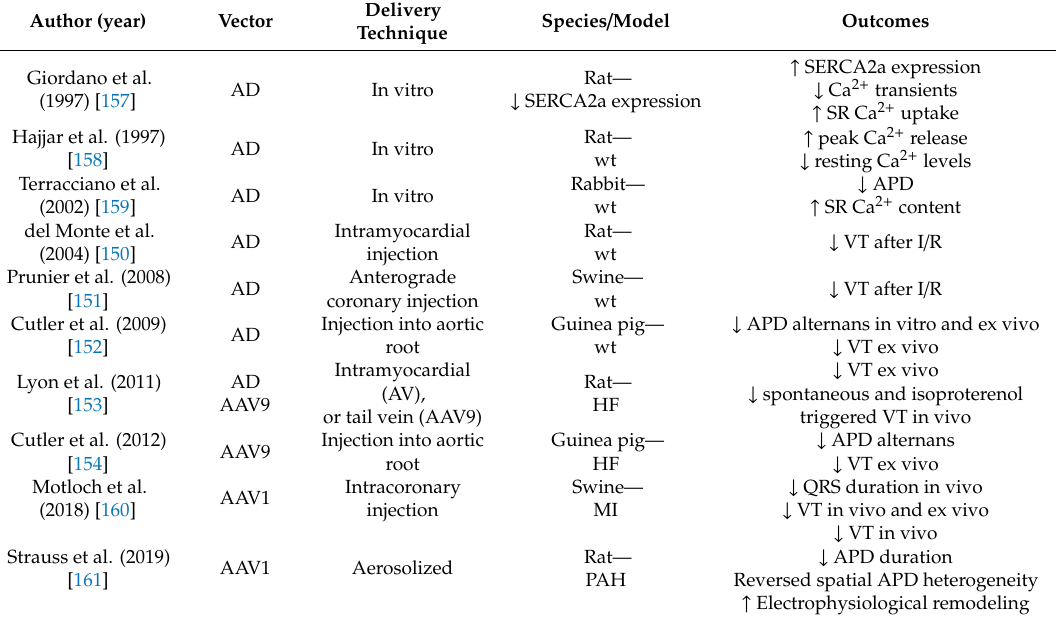
Table 3. Gene therapies to restore cardiac electrophysiology and to prevent ventricular tachyarrhythmias targeting sarco / endo plasmic reticulum calcium ATPase